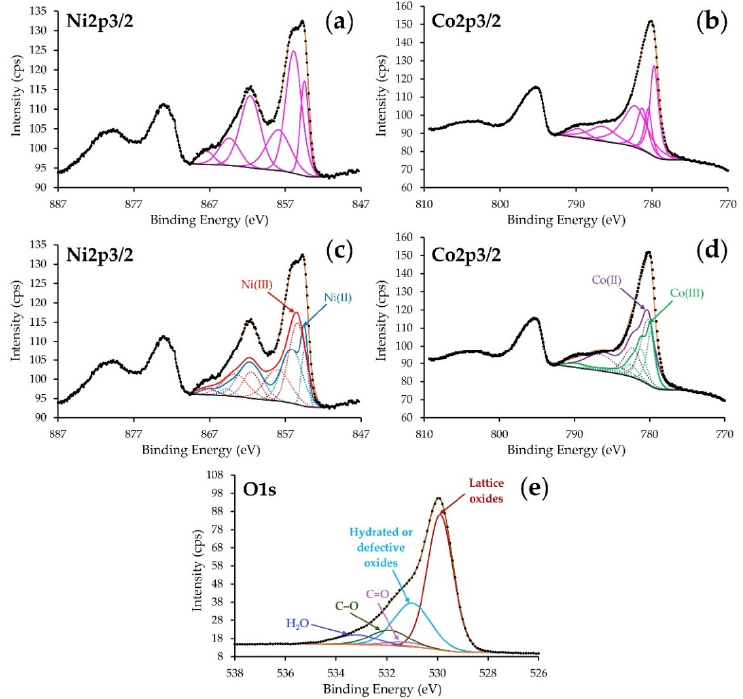
Figure 10. Fitting examples of Ni2p3/2 ( a ) and Co2p3/2 ( b ) spectra of the NiCo 2 O 4 film, including the electronic state of the elements ( c , d ), as well as the results of the O1s spectrum ( e ) analysis. Table 1. Fitting parameters of the Ni2p3/2 and Co2p3/2 spectra without determining the electronic states of the elements: binding energy (eV), percentage of total area, FWHM (eV).